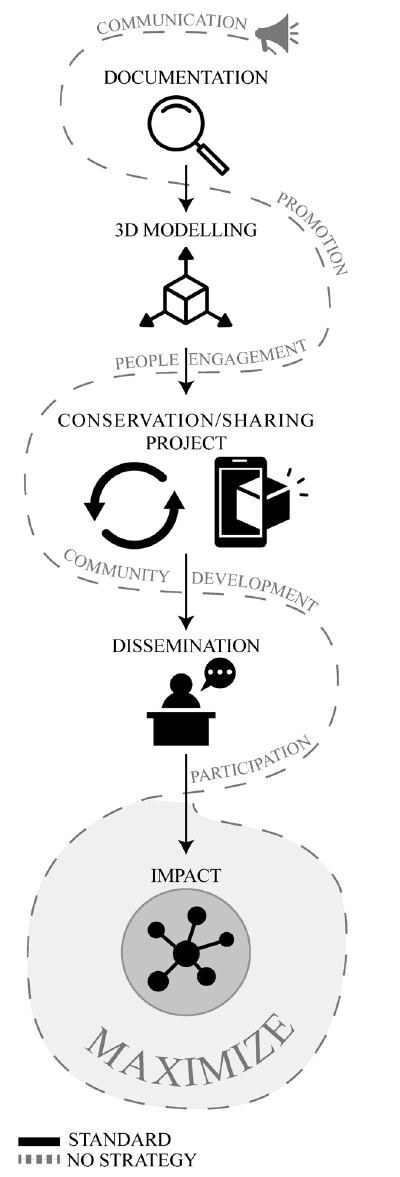
Figure 8. Communication and promotion actions leads to to a maximization of the impact of the “standard” methodology for a valorisation and conservation